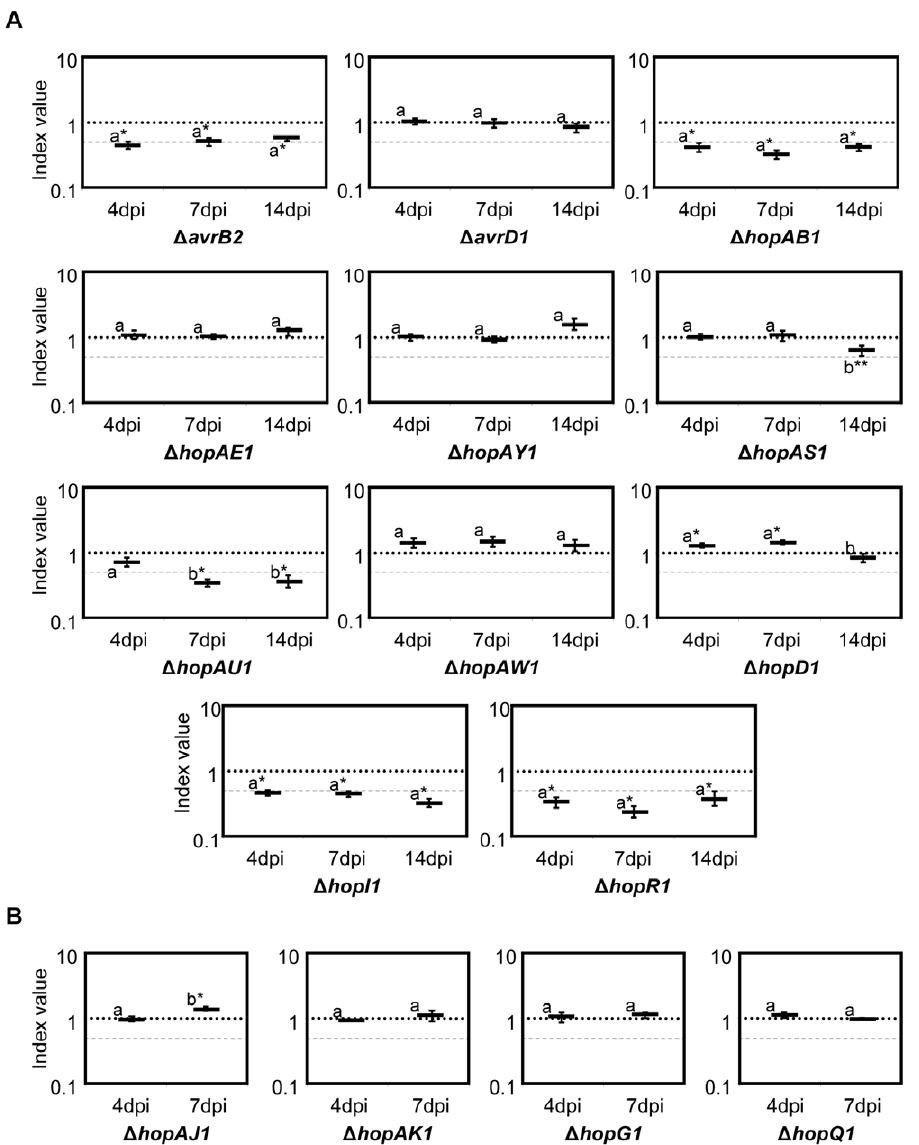
Figure 3. Competitive Index analysis of Pph 1448a effector mutants. Mutant strains were co-infiltrated with the wild type strain, and samples were taken at different time points: A . 4, 7 and 14 days post-inoculation (dpi), or B . 4 and 7 dpi. Competitive indices correspond to the mean of two to four independent experiments with three replicates per experiment. A dashed line corresponding to a CI=0.5 is included for reference. Error bars represent the standard error. Asterisks indicate results significantly different from one, as established by Student’s t-test (P , 0.05). Mean values marked with the same letter (a or b) indicate results not significantly different from each other, as established by One Way ANOVA and Holm-Sidak test for multiple comparison or One Way ANOVA on Ranks and Tukey test for multiple comparison when Equal Variance Test failed ( P , 0.05). Two asterisks indicate that attenuation was right on the limit of significance in each independent experiment or when results were pulled from independent